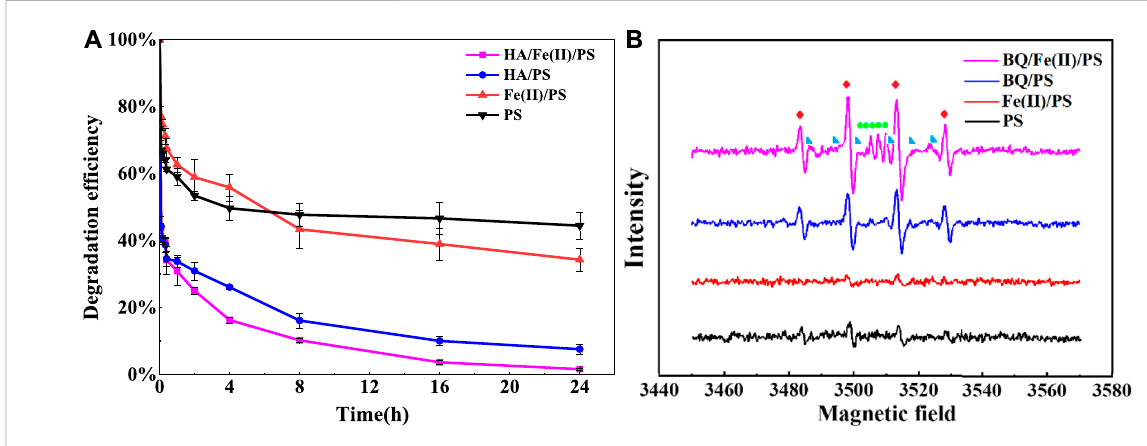
FIGURE 1 (A) Degradation kinetics of FLU under various activation conditions; (B) EPR spectra for the detection of PS, Fe ( Ⅱ )/PS, HA/PS and HA/Fe ( Ⅱ )/PS system. Conditions: [PS]